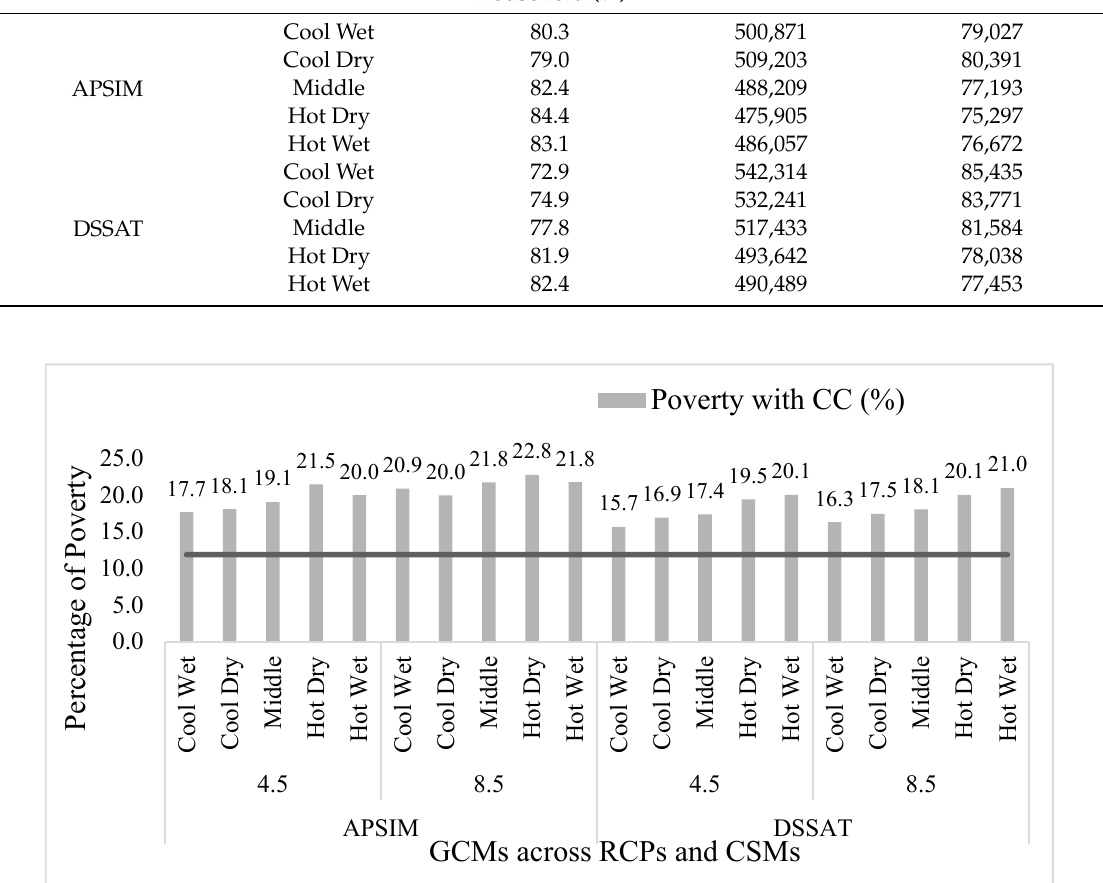
Figure 3. Impact of climate change in the current rice wheat cropping system on poverty.